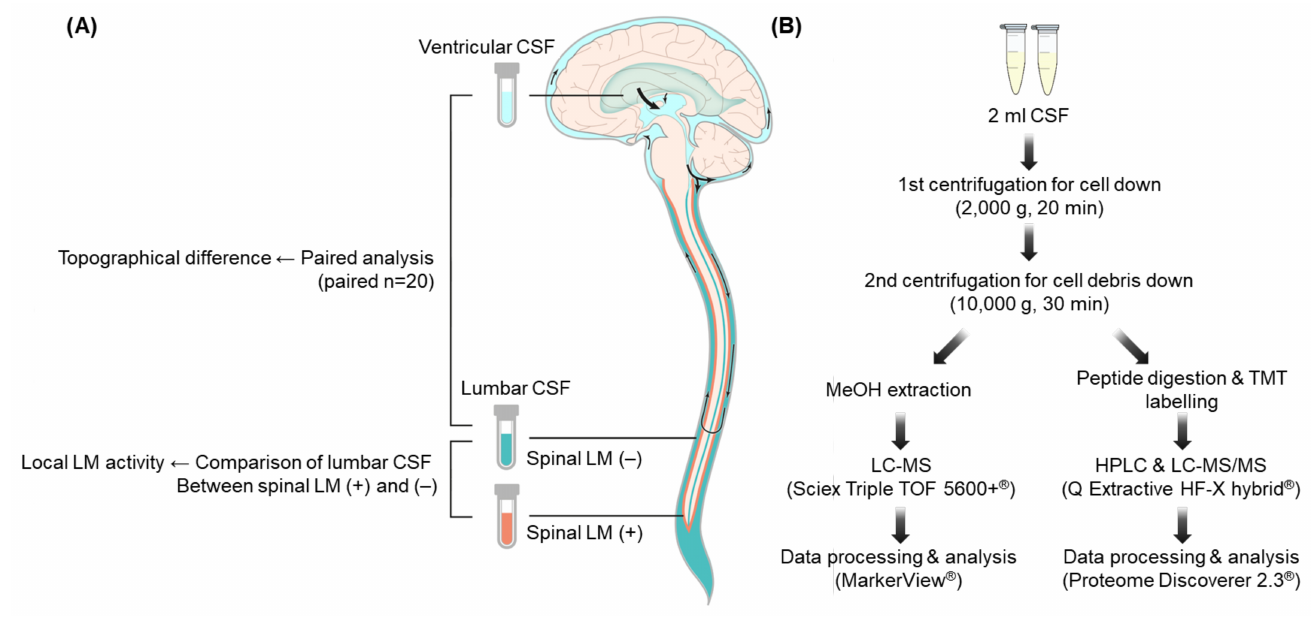
Figure 1. Schematic diagram of the comparative profiling and workflow. ( A ) Illustration of compara- tive profiling of CSF metabolites and proteins according to the compartment and local leptomeningeal metastasis (LM) activity; ( B ) workflow of CSF processing for acquiring extracellular metabolome